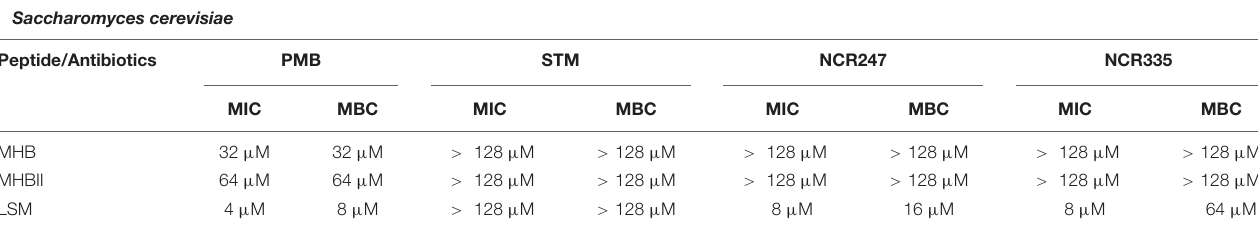
TABLE 3 | Minimal inhibitory concentration (MIC) values determined by colorimetric assay (resazurin) and minimal bactericidal concentrations (MBC) determined by conventional plating method on S. cerevisiae . Saccharomyces